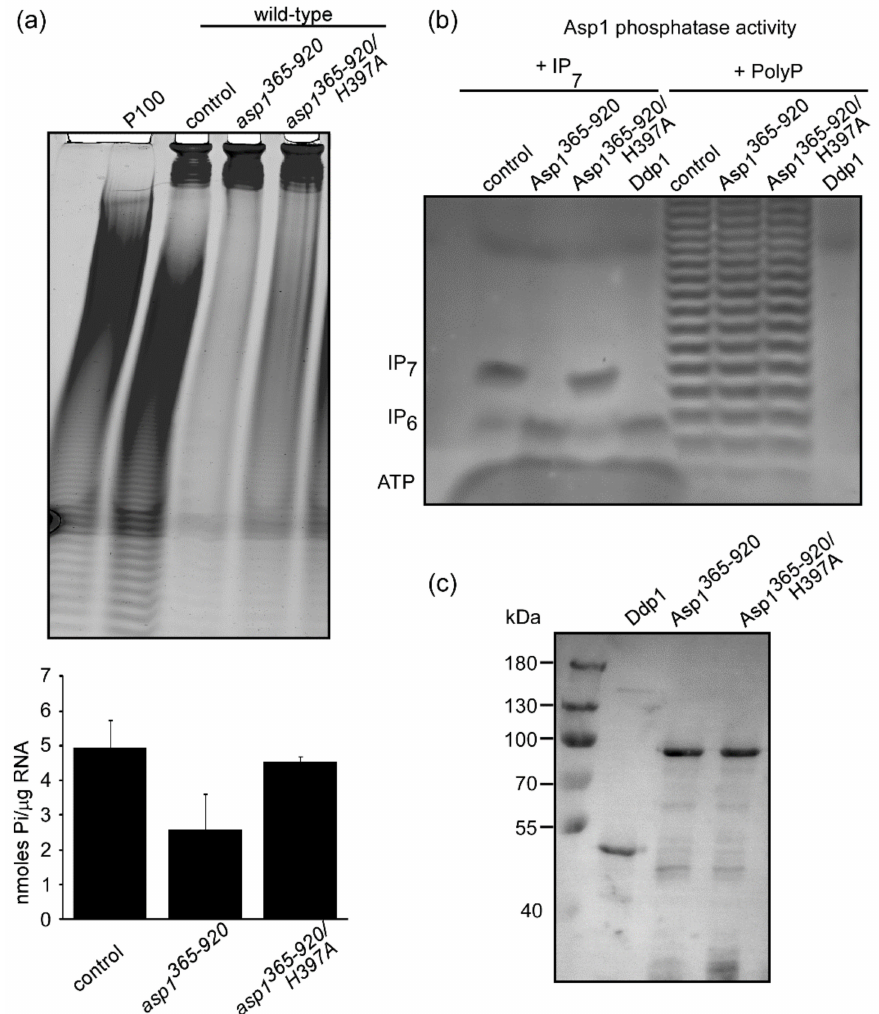
Figure 4. Asp1 phosphatase cannot hydrolyze polyP. ( a ) top panel: polyP analysis (detected as a dark smear by PAGE analysis of lysates) of a wild-type S. pombe strain transformed with either a control plasmid or plasmids expressing asp1 365 − 920 or asp1 365-920/H397A under nmt1 + promoter de-repressed conditions. Bottom panel: quantification of polyP levels using a Malachite Green assay. ( b ) the in vitro phosphatase activity of the proteins Asp1 365 − 920 , Asp1 365 − 920/H397A , or S. cerevisiae Ddp1 were determined using IP 7 (left panel) or polyP (right panel) as substrate. ( c ) Western blot analysis of GST-tagged proteins Ddp1, Asp1 365 − 920 , and Asp1 365-920/H397A expressed and purified from